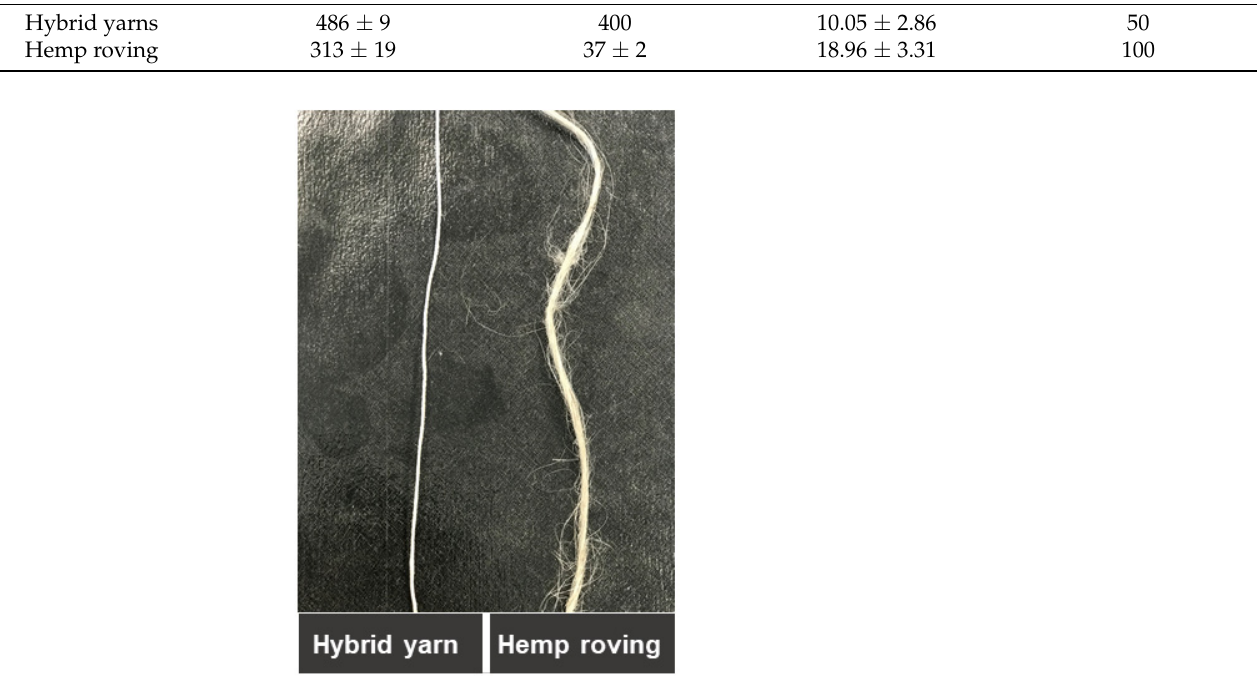
Figure 4. The visual aspect of a hybrid yarn and a hemp